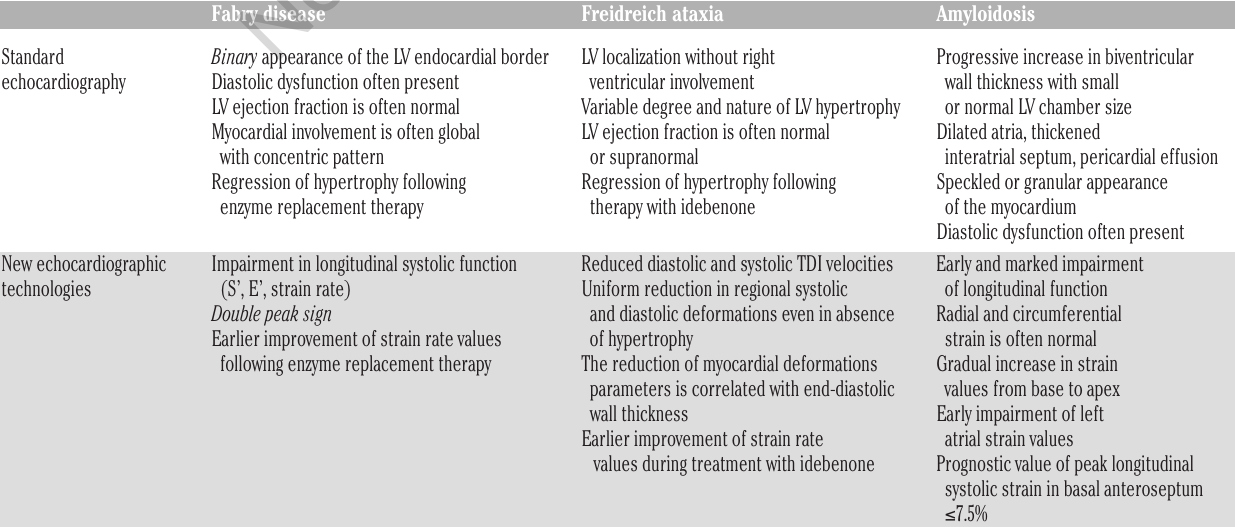
Table 1. Main features concerning standard and new echocardiographic findings in Fabry disease, Friedreich ataxia and amyloidosis. Fabry